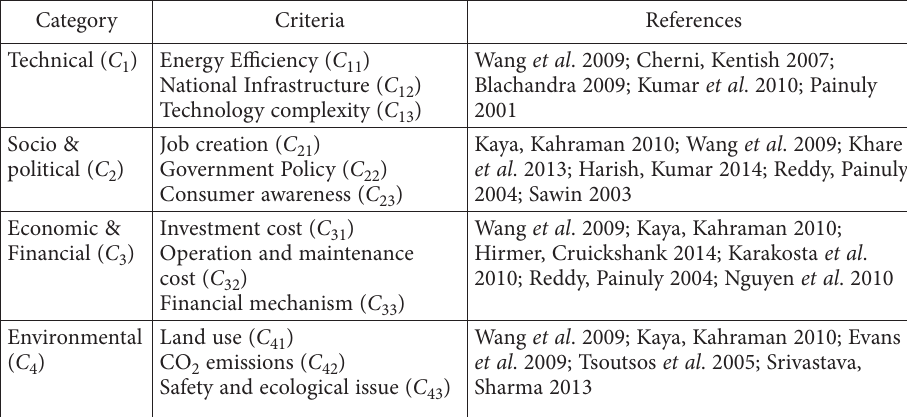
Table 2. Criteria taken into account to select the best renewable energy Category